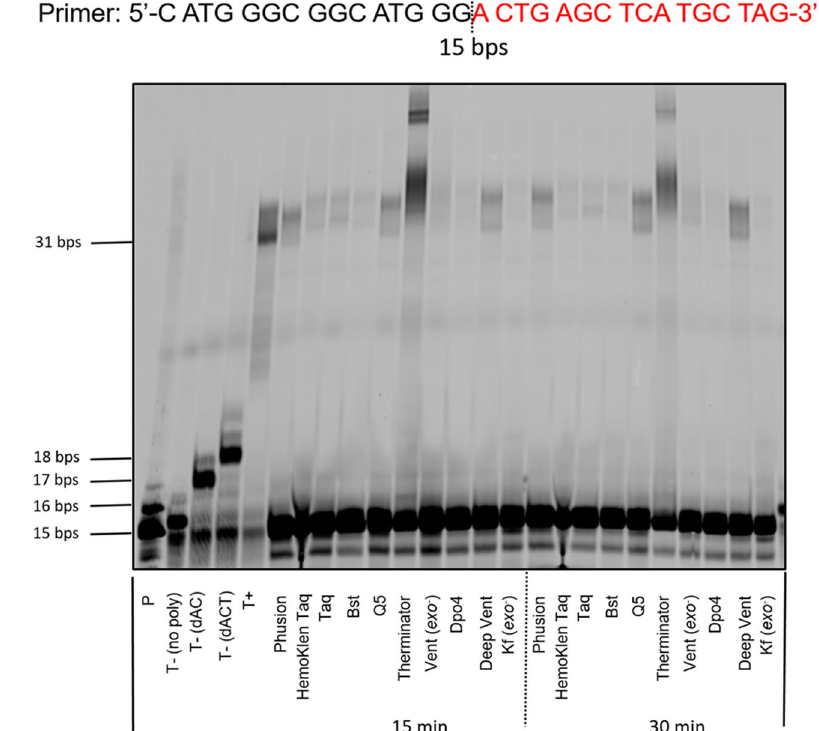
Fig. 1 Blocking enzymatic synthesis with a 3 ′ -phosphorylated primer. Gel image (PAGE 20%) shows the result of the PEX reactions with 3 ′ - phosphorylated primer P1 and template T1 with natural dNTPs and different DNA polymerases. Natural triphosphates were at a fi nal concentration of 200 µ M. The following quantities of polymerases and reaction conditions were used: Phusion (2 U), Hemo Klen Taq (8 reactions), Taq (5 U), Bst (8 U), Q5 (2 U), Therminator (2 U), Vent ( exo − ) (2 U): 60 °C, 15 min and 30 min; Dpo4 (2 U), Deep Vent (2 U): 55 °C, 15 min and 30 min; Kf ( exo − ) (5 U): 37 °C, 15 min and 30 min. Negative control (T − ): No polymerase added to the mixtures or reactions only with dATP and dCTP or dATP, dCTP, and dTTP only. Positive control (T + ): with all natural nucleotides and Taq polymerase. All reactions were incubated at adequate reaction temperatures for 1 h. P represents unreacted, 5 ′ -FAM-labeled